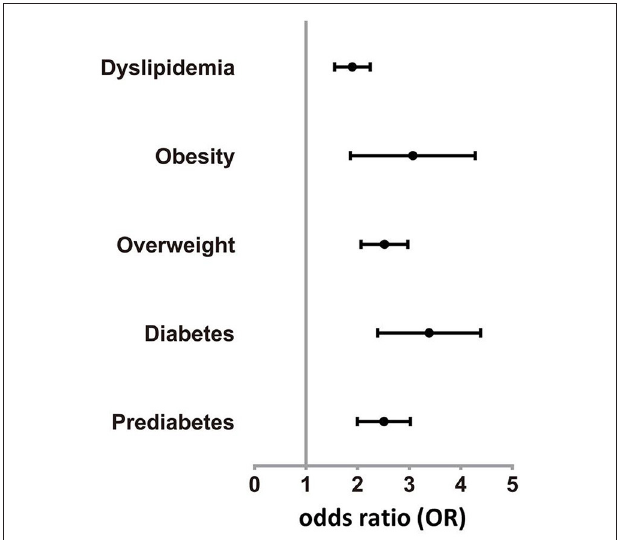
FIGURE 2 | Odds rate of various diseases in NJ. Prevalence of prediabetes, diabetes, overweight, obesity, and dyslipidemia in NJ were higher than SY.